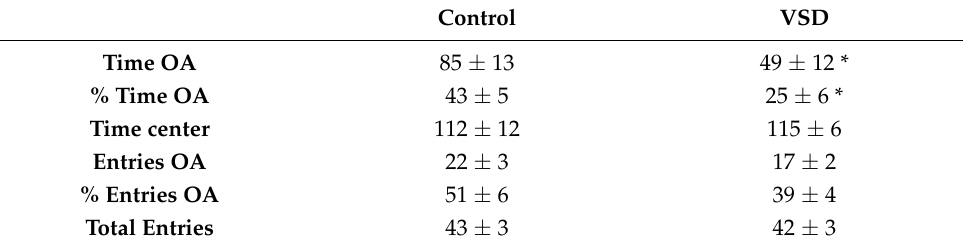
Table 1. VDS increases anxiety in female mice. * p < 0.05 significant difference compared to the control